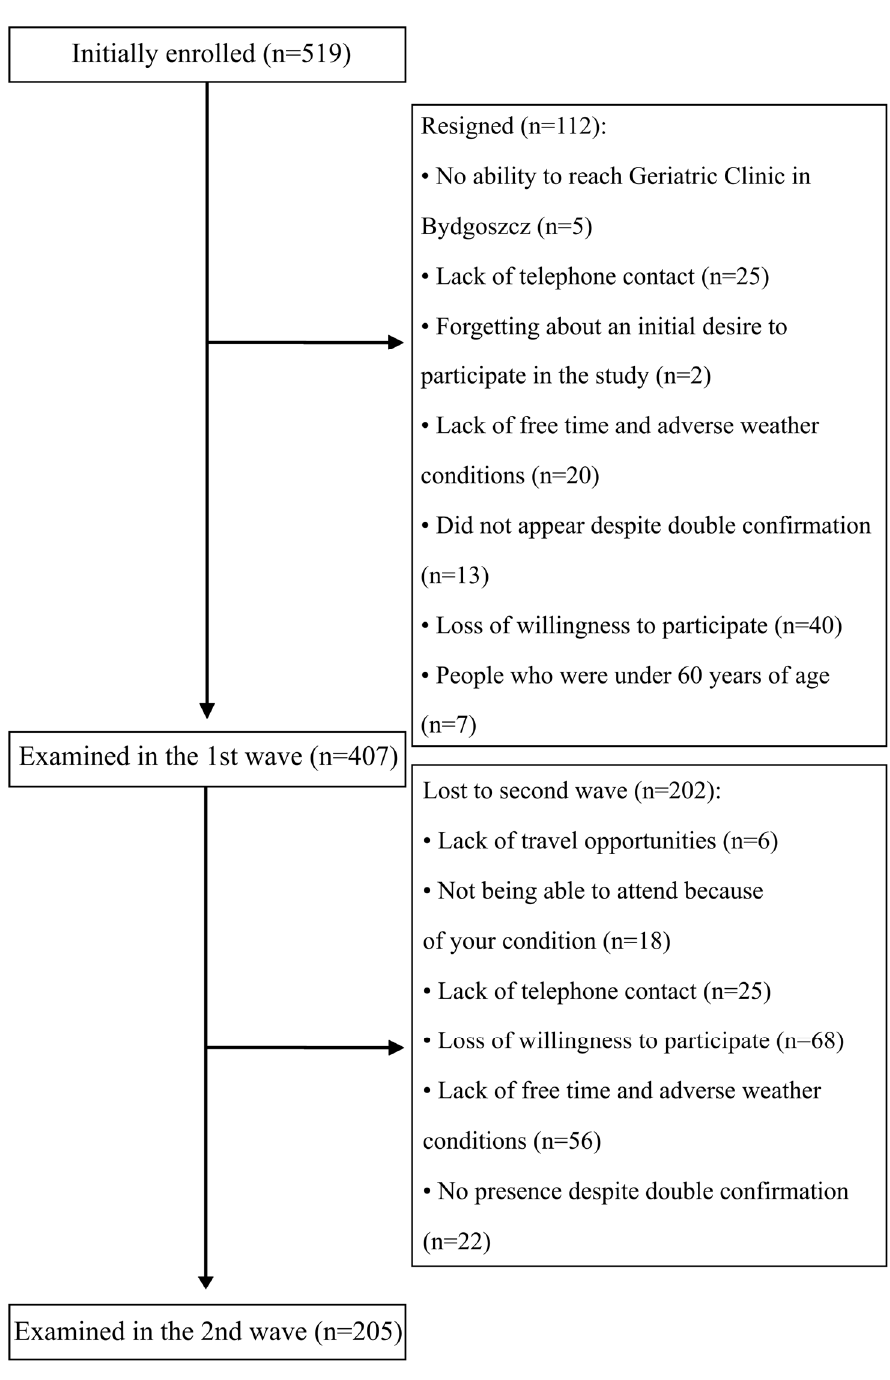
Figure 1. Flow chart of the study. Recruitment of subjects was done via advertisements on regional television and radio, during the delivery of health-promoting public lectures at Collegium Medicum